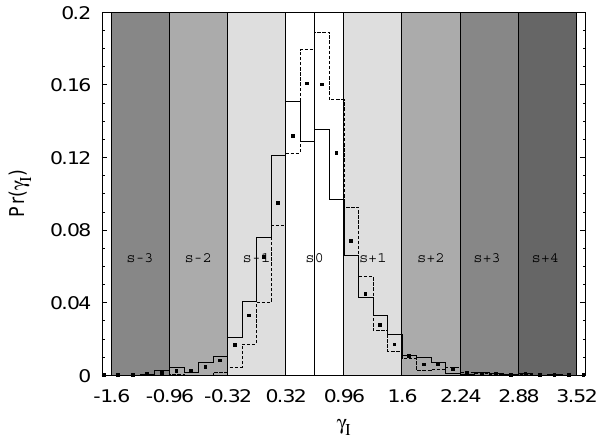
Fig. 1. The probability Pr( γ I ) for the entire (full squares), stratiform (dashed line), and convective (solid line) datasets at Darwin. The shaded regions indicate different skewness